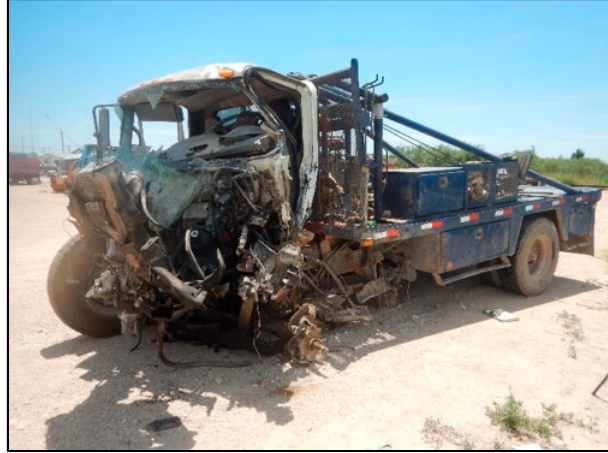
Figure 6. International truck, post-collision, left front ¾ view.